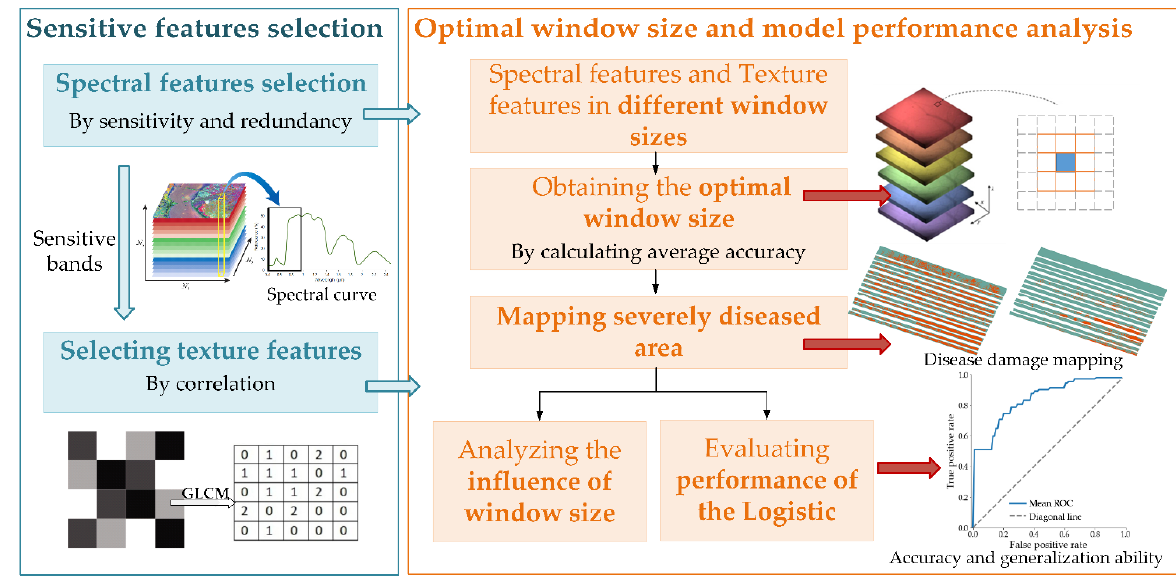
Figure 2. Methodological framework. A portion of the image material comes from Giannoni et al. (https://www.nireos.com, accessed on 20 December 2018).